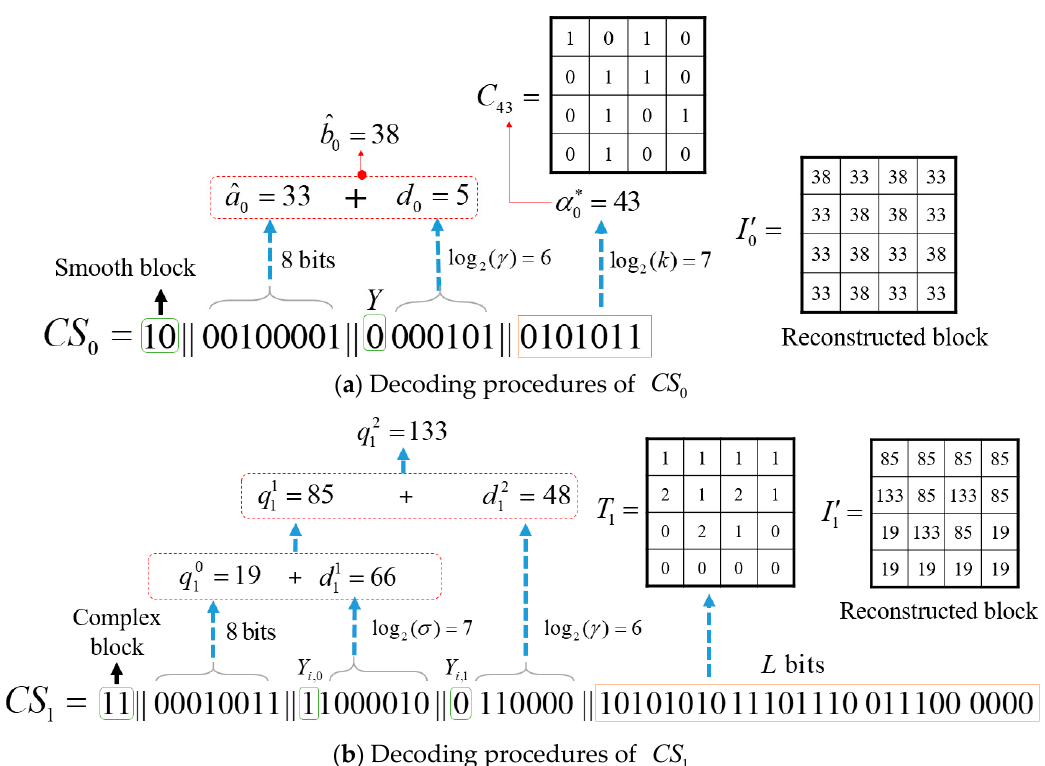
Figure 3. Illustration of the decoding procedures of image blocks.